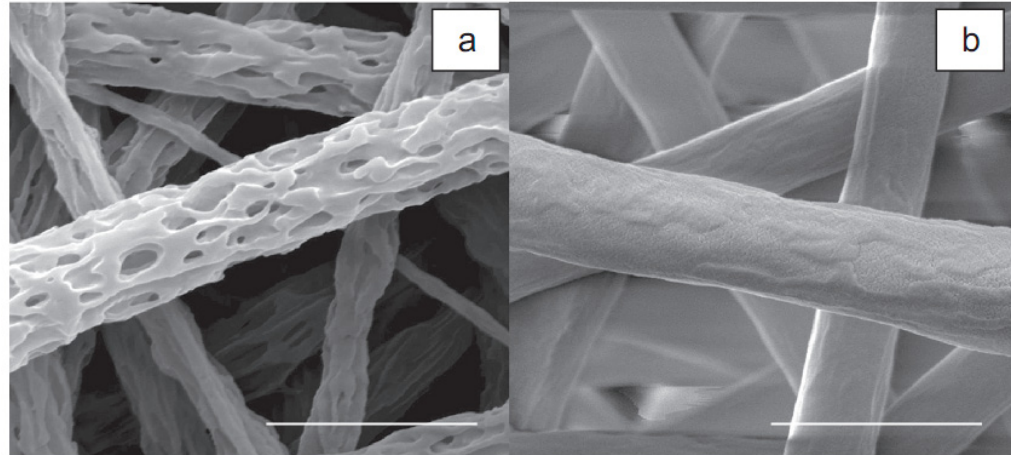
Figure 3. SEM images of 3-D porous material: ( a ) after gelatin is removed from the composite material electrospun Gt/PCL; ( b ) 2 μ m scale tape adapted with permission from [38].